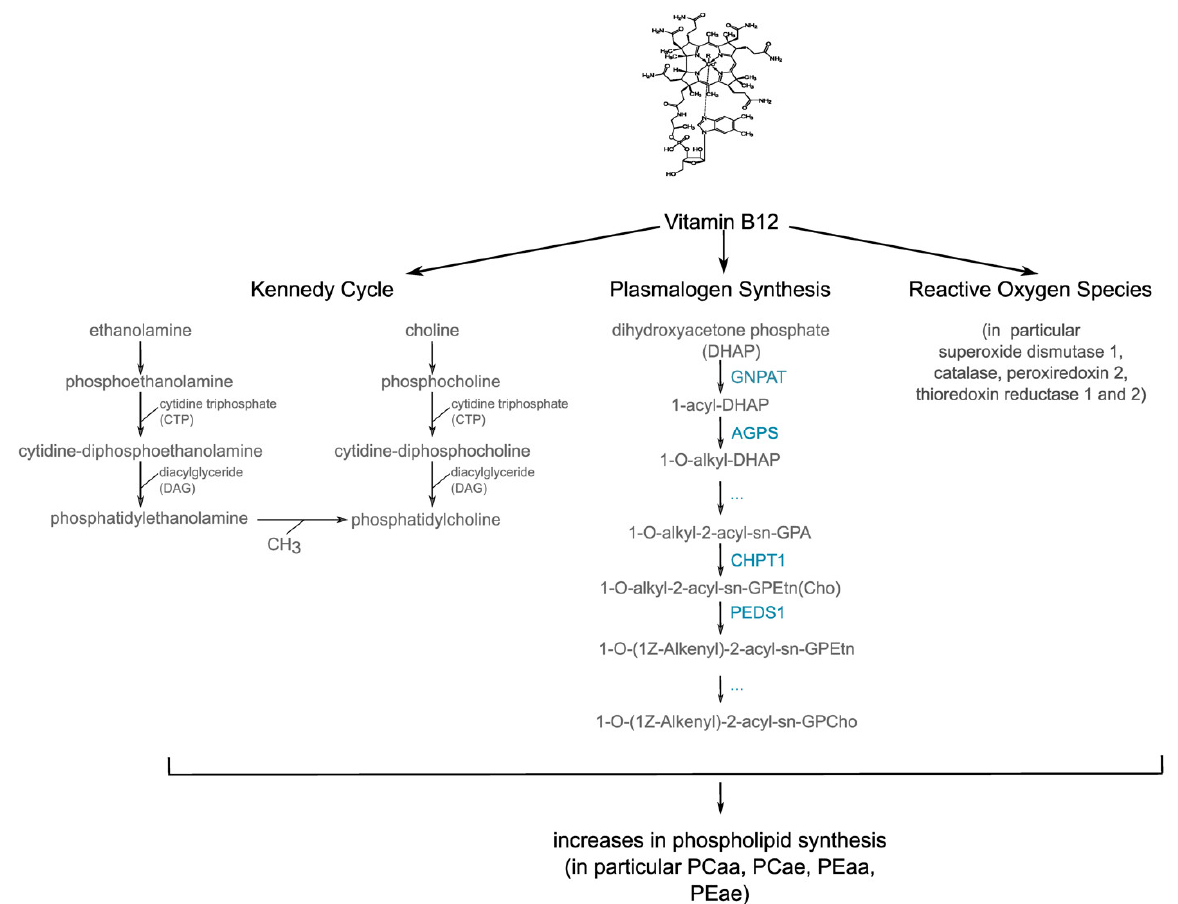
Figure 6. Schematic summary of the link between vitamin B12, the Kennedy cycle, plasmalogen synthesis, and reactive oxygen species (ROS).